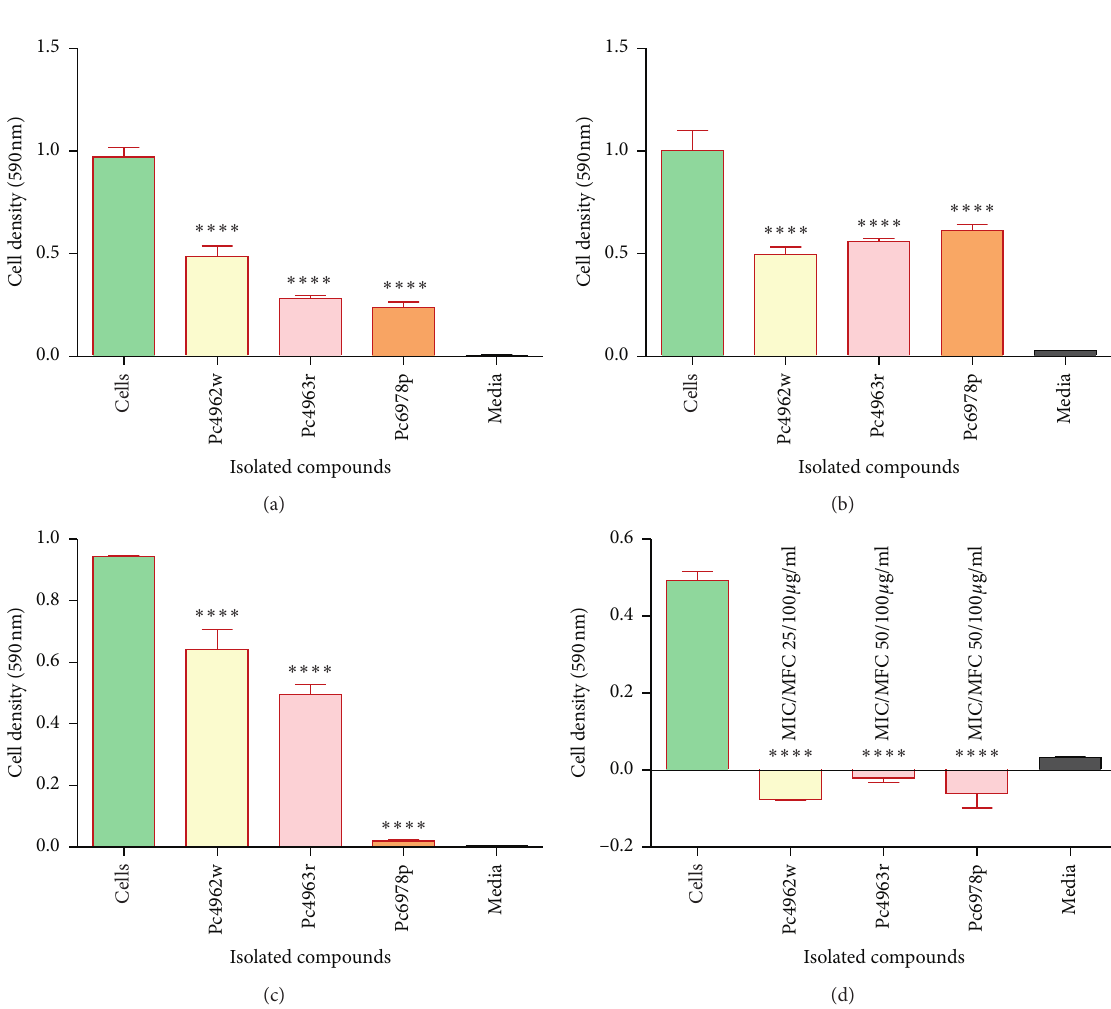
Figure 8: In vitro antibacterial effects of the isolated compounds at a concentration of 100 µ g/mL against S. aureus (a), K. pneumoniae (b), M. smegmatis (c), and C. krusei (d). “Media” column is the negative control showing no cell growth. “Cells” column is the positive control for cell growth. Error bars represent the standard deviation from mean ( n � 4). The asterisk ( ∗ ) indicates the significant difference from the positive control using statistical one-way ANOVA (where ∗ P < 0 . 05, ∗ ∗ P < 0 . 01, ∗ ∗ ∗ P < 0 . 001, ∗ ∗ ∗ ∗ P < 0 .